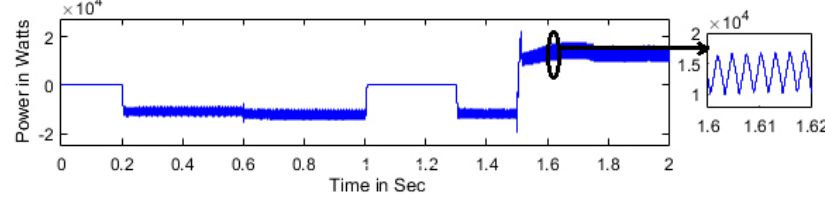
Figure 20. Power flow at point ‘P ’ indicating autonomous and grid connected mode of operation.